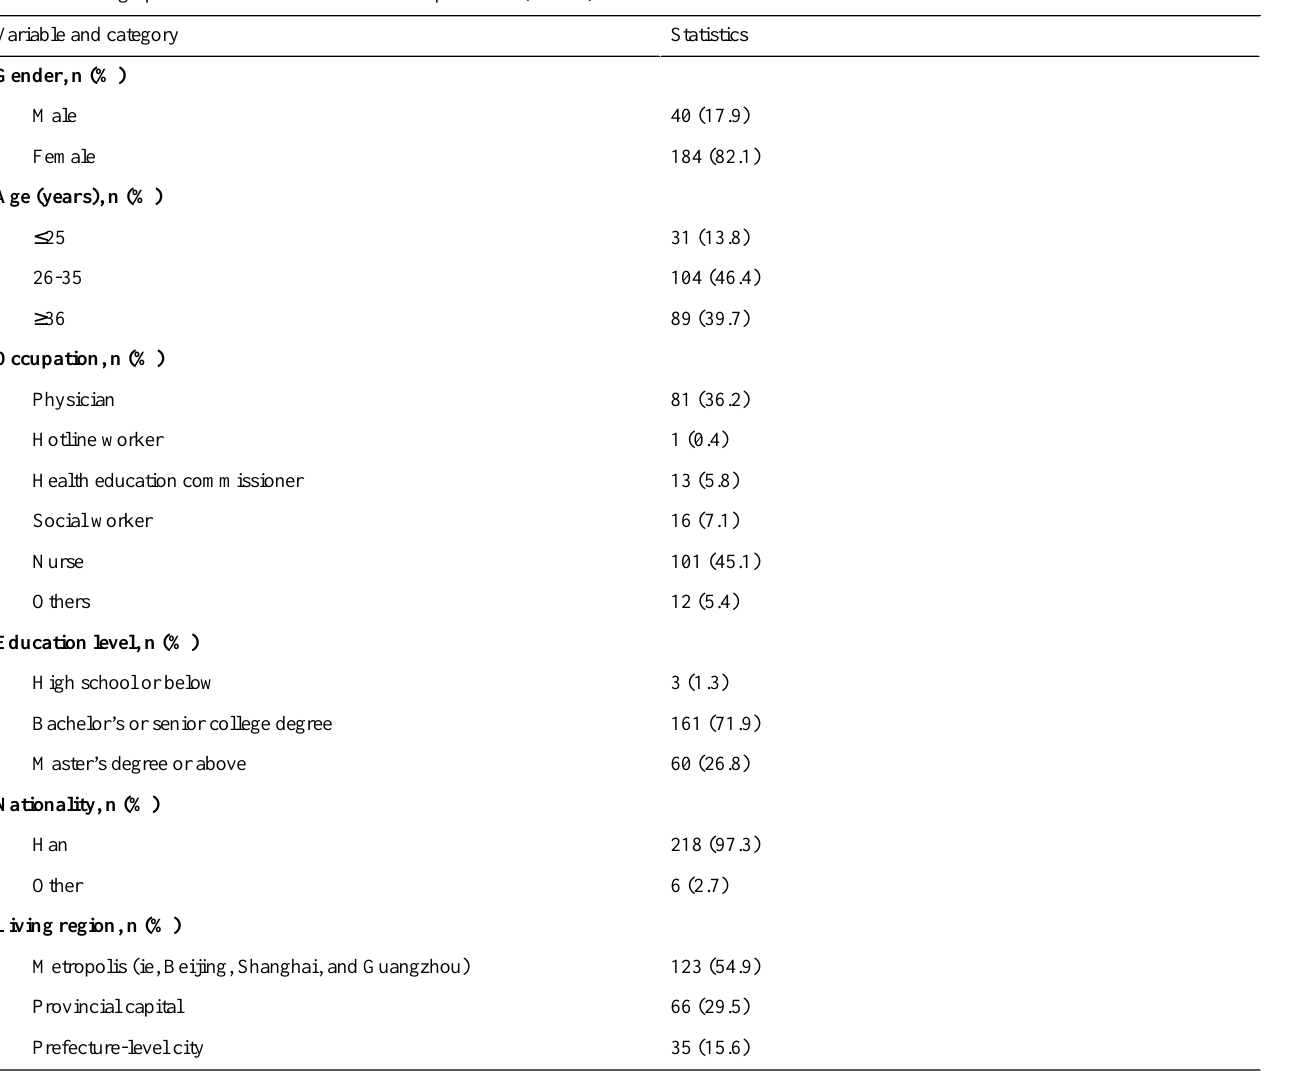
Table 2. Demographic characteristics of health care providers